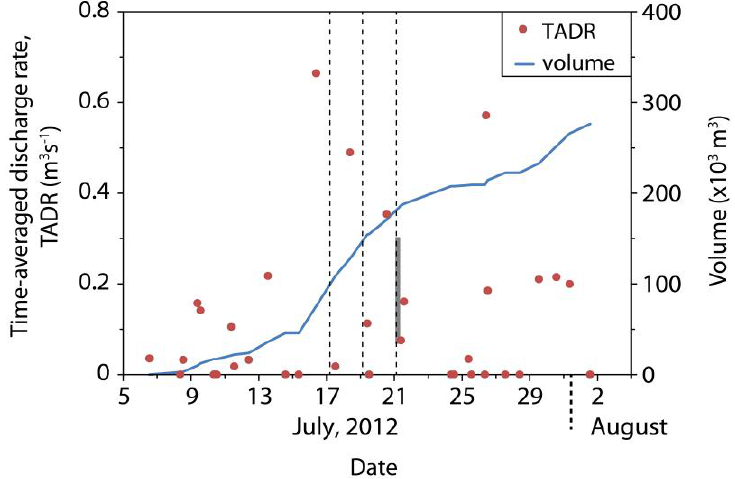
Figure 8. MODIS-derived TADR and cumulative erupted volume estimates. The dashed vertical lines indicate the acquisition start times of the TLS cone scans, and the grey bar represents the range of the TLS-derived TADR values (Figure